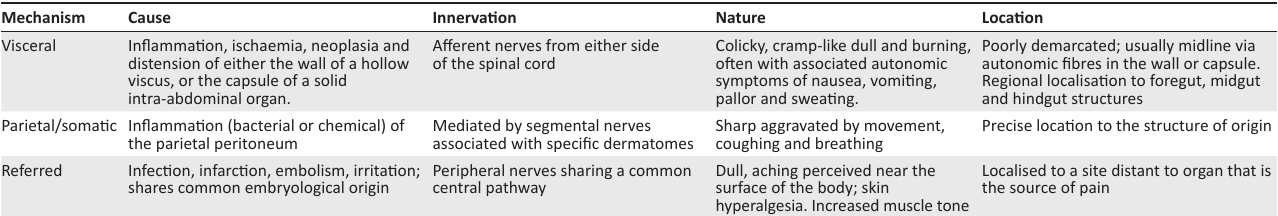
TABLE 2: Mechanisms of abdominal pain. Mechanism Cause Visceral